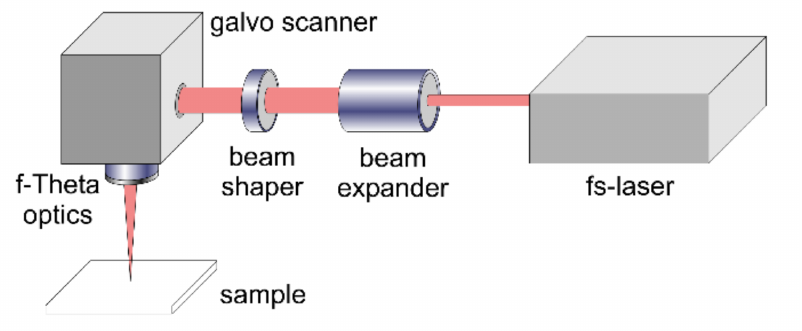
Figure 4. Experimental setup used for surface structuring